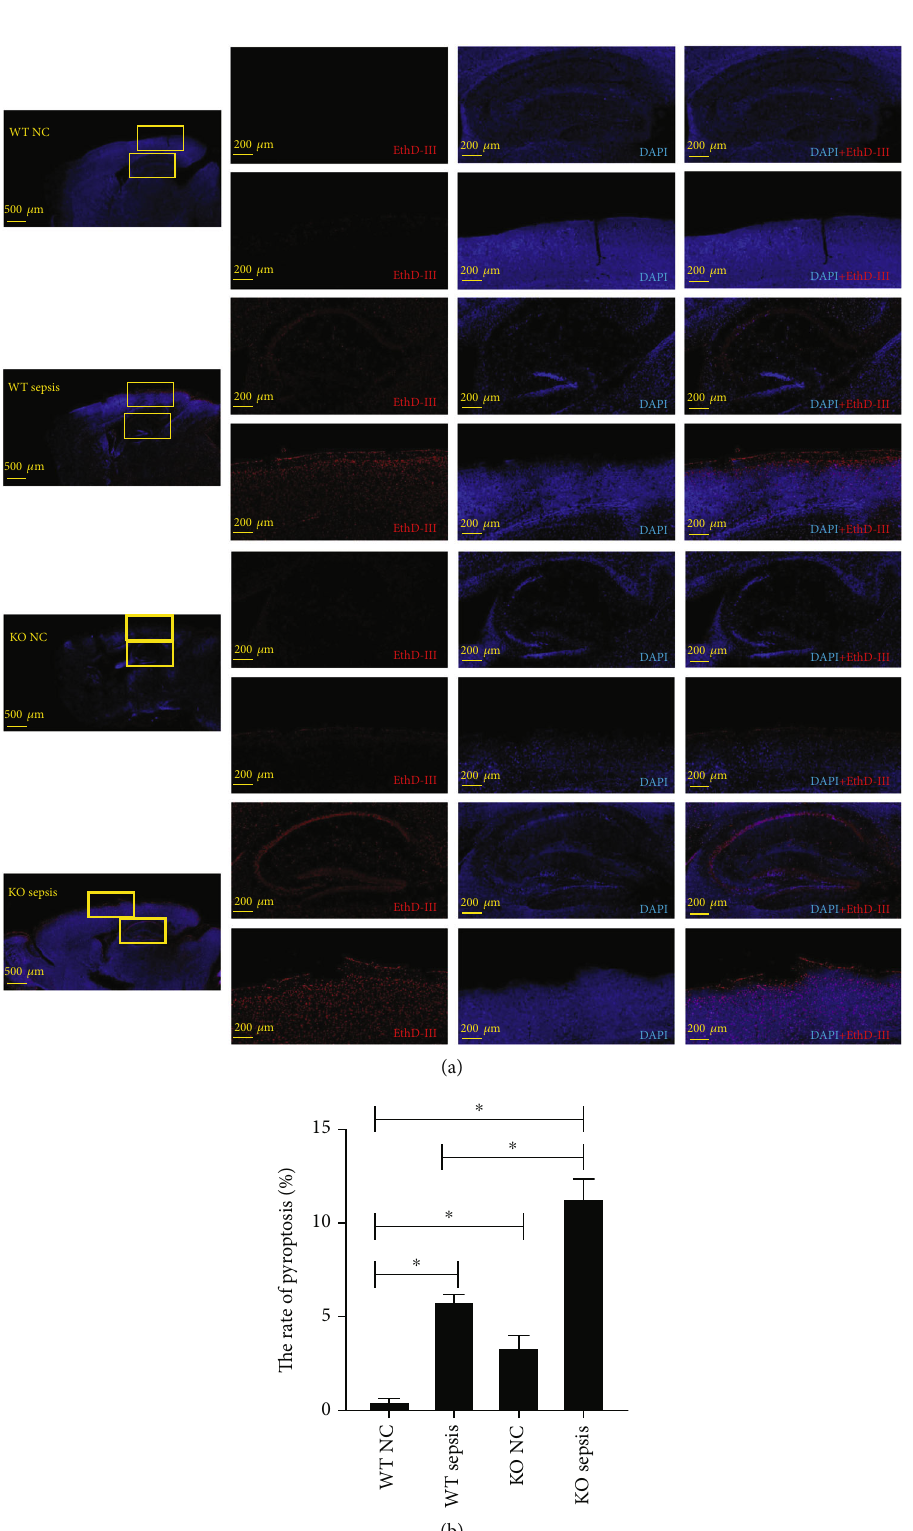
Figure 2: Pyroptosis in brain tissues of di ff erent mouse groups. (a) EthD-III staining (red) was labeled as pyroptosis, and DAPI staining (blue) was tagged as nuclei. The photos were taken by the laser scanning microscope at 500 μ m (apply to the fi rst column from the left side) and 200 μ m (apply to the second to fourth columns from the left side). (b) The statistical analysis of pyroptosis is shown in the graph. Experiments were repeated independently, ∗ p < 0 : 05 . WT NC: wild-type negative control group; WT S: wild-type sepsis group; KO NC: hsf1 -/- negative control group; KO S: hsf 1 -/- sepsis